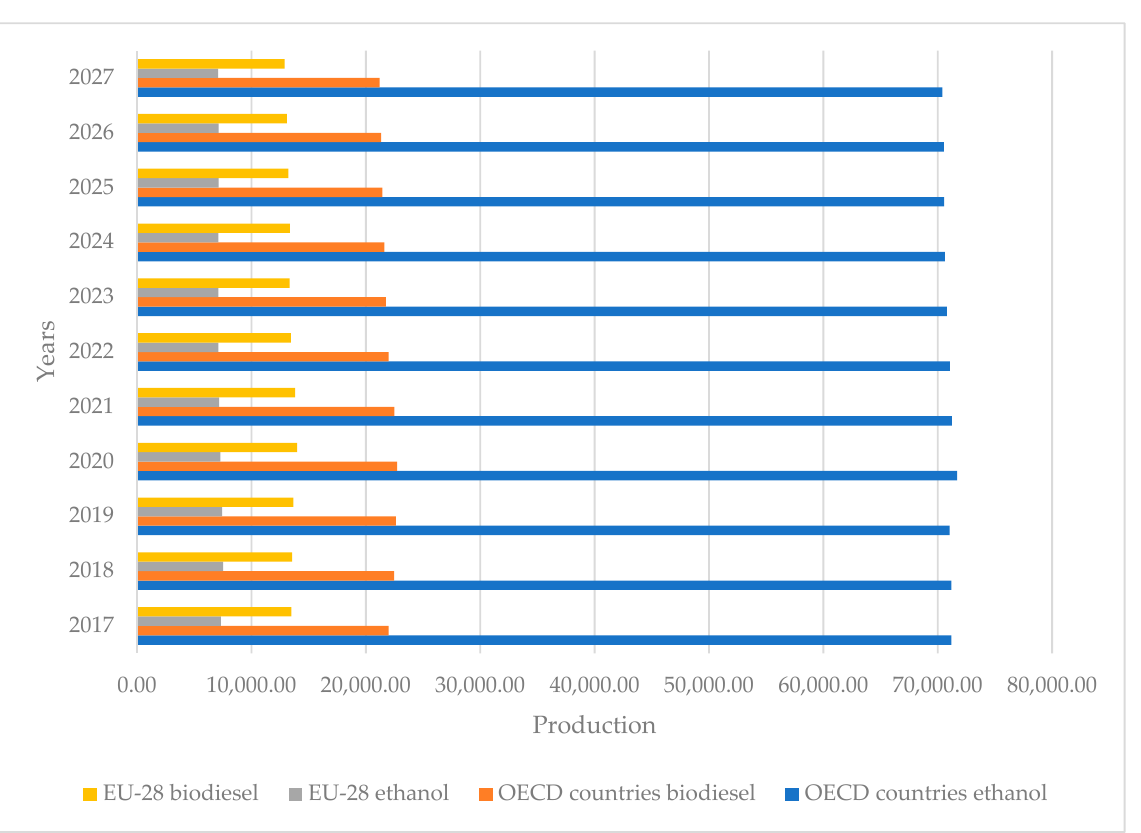
Figure 5. Biodiesel and ethanol production and outlook. Source: FAOSTAT 2018. OECD-FAO Agricultural Outlook 2018–2027: BIOFUEL—OECD-FAO Agricultural Outlook 2018–2027. https: //stats.oecd.org/Index.aspx?DataSetCode=HIGH_AGLINK_2018 (accessed on 10 June 2021)